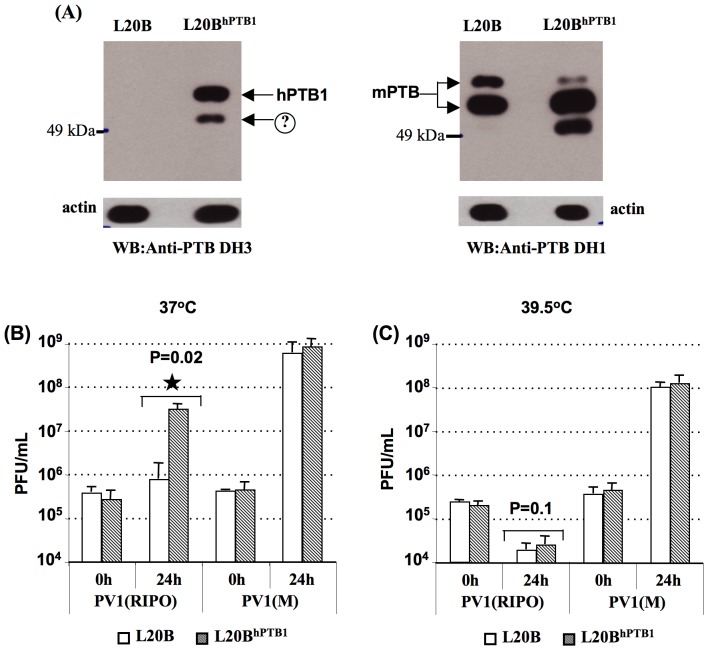
Expression of hPTB1 in L20B cells and its effect on viral growth.(A) Expression of PTB in parental L20B cells versus L20BhPTB1 cells was shown using two different monoclonal antibodies to PTB. Left blot: The upper band migrating with an apparent molecular mass of ∼57 kDa represents the exogenously expressed hPTB1. A new minor PTB species migrating with a slightly smaller apparent mass than the major band is indicated with a question mark (?). Right blot: The antibodies used here detected the endogenous mouse PTB (mPTB) in addition to the exogenous hPTB1. Actin was detected as a loading control. (B) and (C) Comparison of the growth phenotype of PV1(RIPO) and PV1(M) in the parental L20B cells and with that in L20BhPTB1 cells at 37°C and 39.5°C, respectively, at an MOI of 10. In all cases, averages ± SD of at least three independent experiments are shown; <$>\raster="rg1"<$> denotes student t-test p value <0.05.